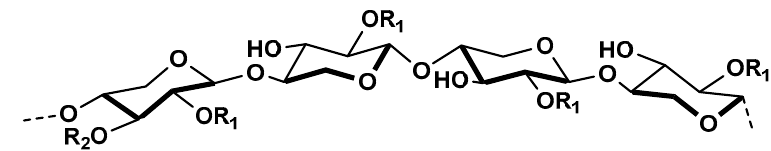
Figure 6. Main chemical structure of xylans. With R 1 and R 2 are H or different side